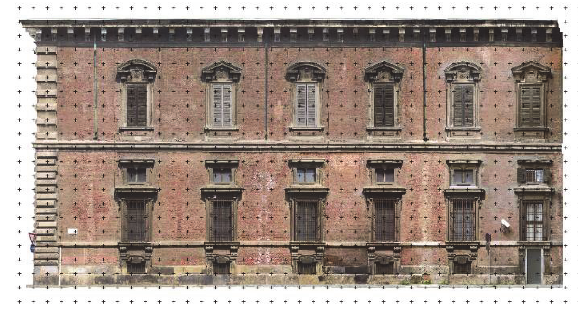
Figure 4: Palazzo Brera (Mi) 2003. Forehead on “Piazzetta Brera” rectified image to the scale 1:50. The photographic acquisition was done with not-metrics digital camera Olympus C-3040 zoom - 3,3 megapixels. The 38 photos with a resolution